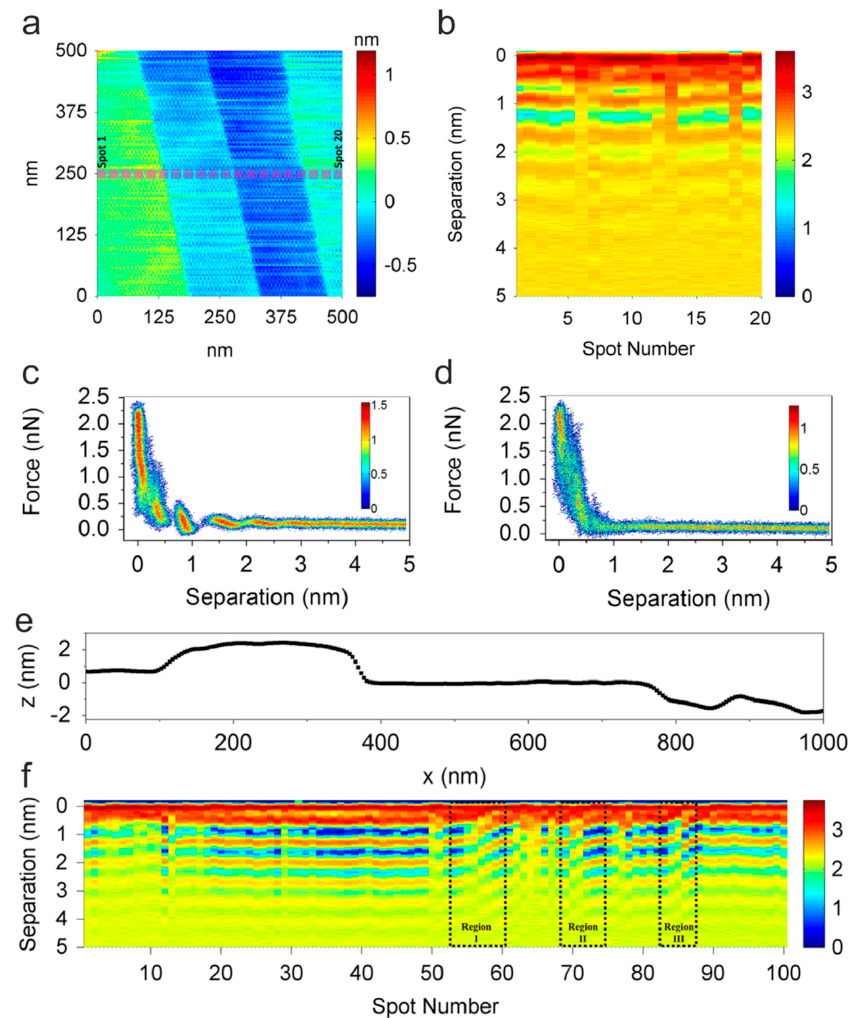
Figure 17. Influence of topological defects on the interface structure between highly oriented pyrolytic graphite (HOPG) and [EMIm][TFSI]. ( a ) Topography of HOPG; ( b ) force–separation curves measured at 20 points as marked in ( a ); ( c ) force–separation histograms obtained on the basal plane; and ( d ) from the step edge; ( e ) topography line profile with a length of 1 µ m; ( f ) force–separation curves measured along the line in ( e ) showing di ff erent defect regions. Adapted with permission from Black et al. [122]. Copyright 2015,